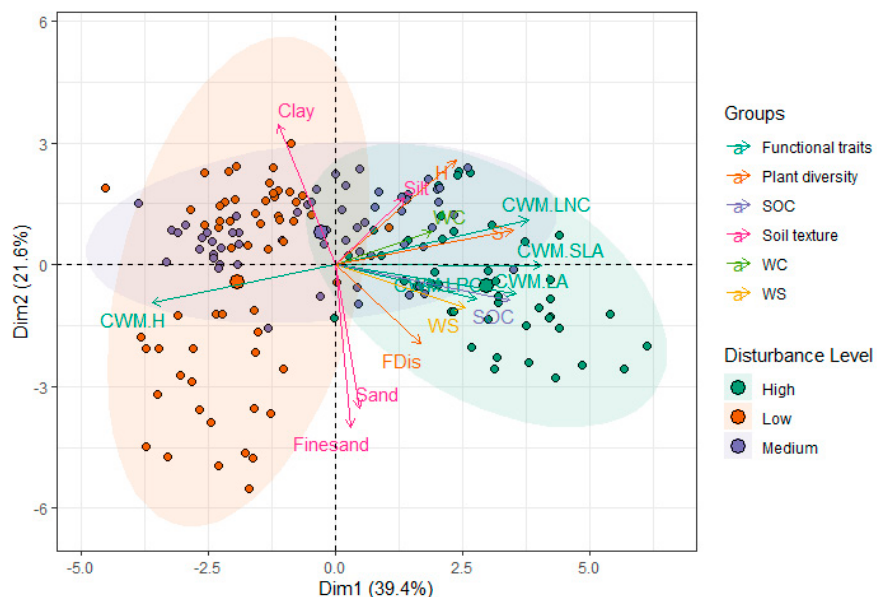
Figure 3. The principal component analysis (PCA) of soil water retention and all predictors. PC1 and PC2 explain 61% of the total variance. Circles of different colors mean three disturbance levels.